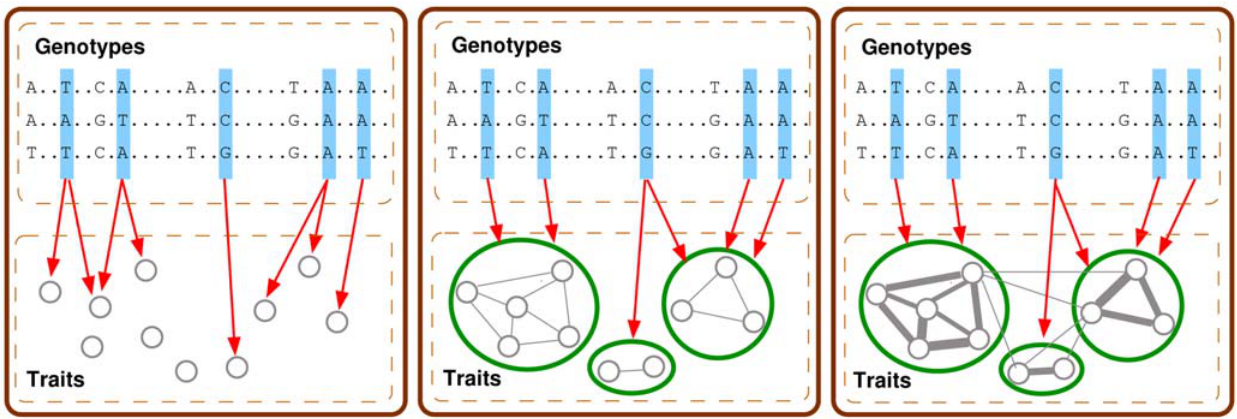
Figure 2. Illustrations for association analysis with multiple quantitative traits using various regression methods. (A) In lasso, each phenotype represented as a circle is independently mapped to SNPs for association. (B) In graph-constrained fused lasso ( G c Flasso ), we consider a QTN to search for an association between a SNP and a subnetwork of traits. (C) In graph-weighted fused lasso ( G w Flasso ), we consider a QTN with edge